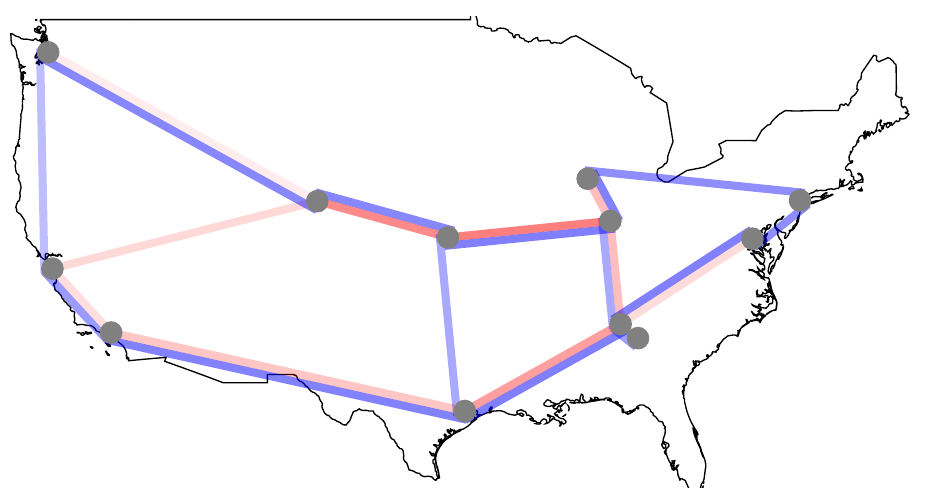
Figure 14. Wavelength assignment for band C and L (with max demand) for American network.